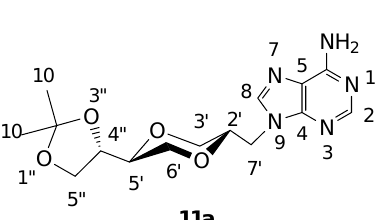
Figure 8. Structure 11a .